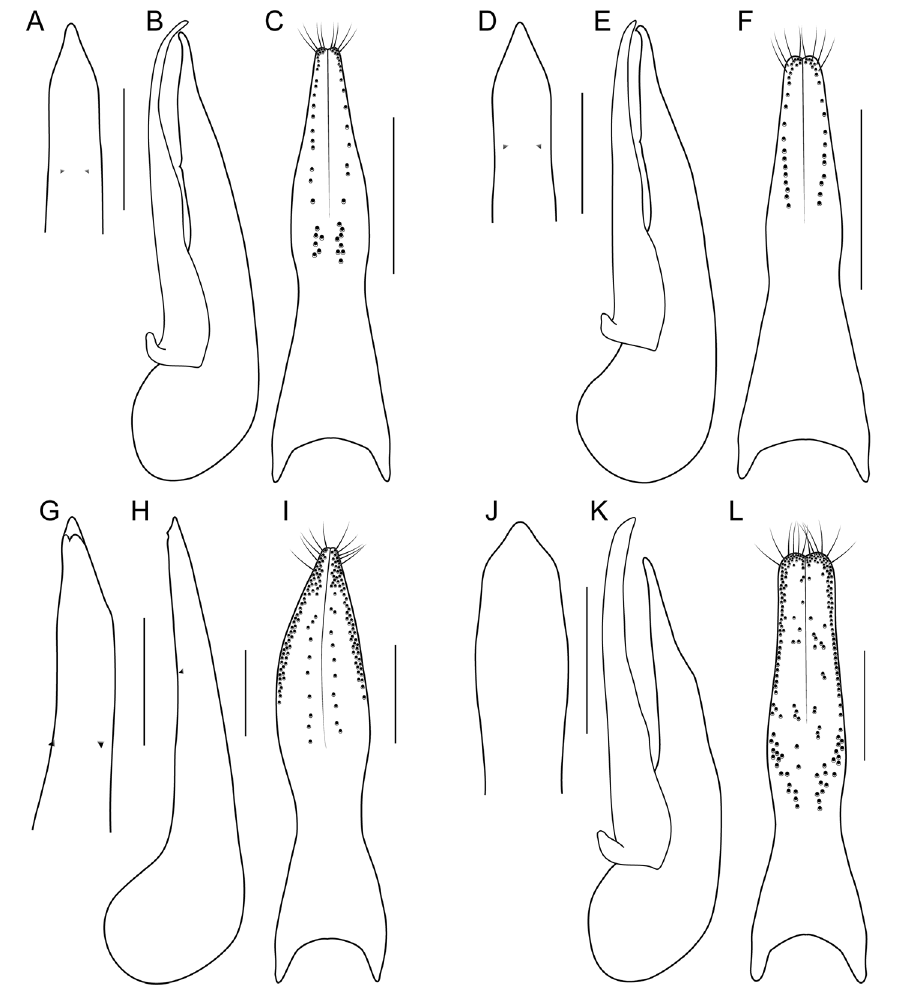
Figure 18. Bolitogyrus elegans (Cameron) ( A–C ), B. ornatipennis (Wendeler) ( D–F ), B. doesburgi (Scheerpeltz) ( G–I ) and B. signatus (Cameron) ( J–L ). Median lobe in parameral view ( A, D, G, J ), median lobe in lateral view ( H ), aedeagus in lateral view ( B, E, K ), peg setae of paramere ( C, F, I, L ). Scale bars: 0.5